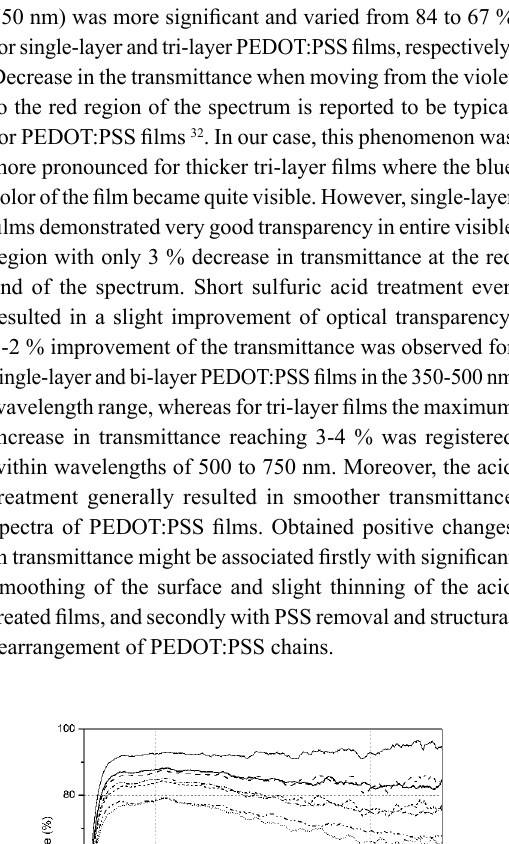
After sulfuric acid treatment of PEDOT:PSS+DMSO